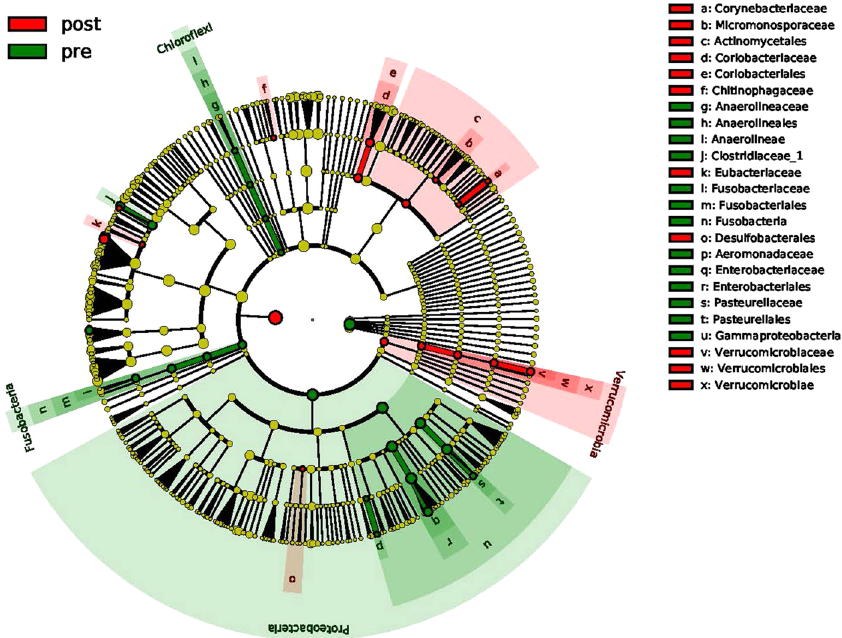
Figure 4. A cladogram plot of differential species abundance between the pre-LT and post-LT groups is shown. The red and green areas represent the species enrichment in the post-LT and pre-LT groups, respectively.